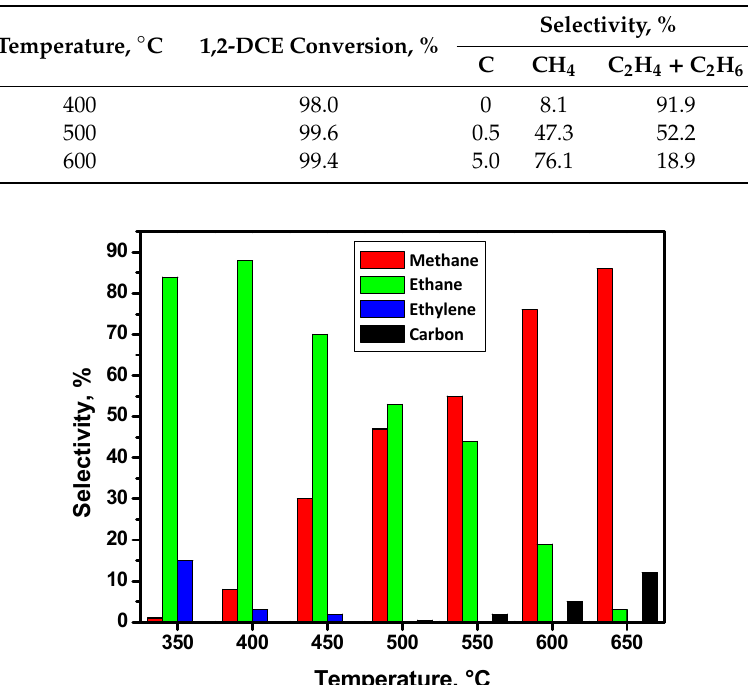
Table 1. Catalytic properties of the Ni / Al 2 O 3 catalyst in the hydrodechlorination of 1,2-DCE at different temperatures.